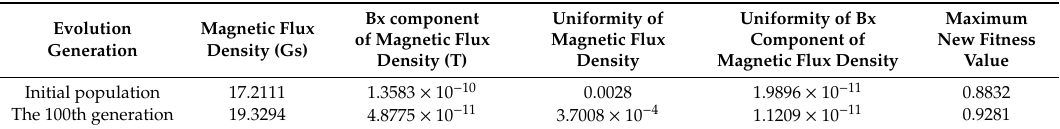
Table 4. Comparison of detection platform performances before and after Genetic Algorithm optimization (the individual with maximum new fitness